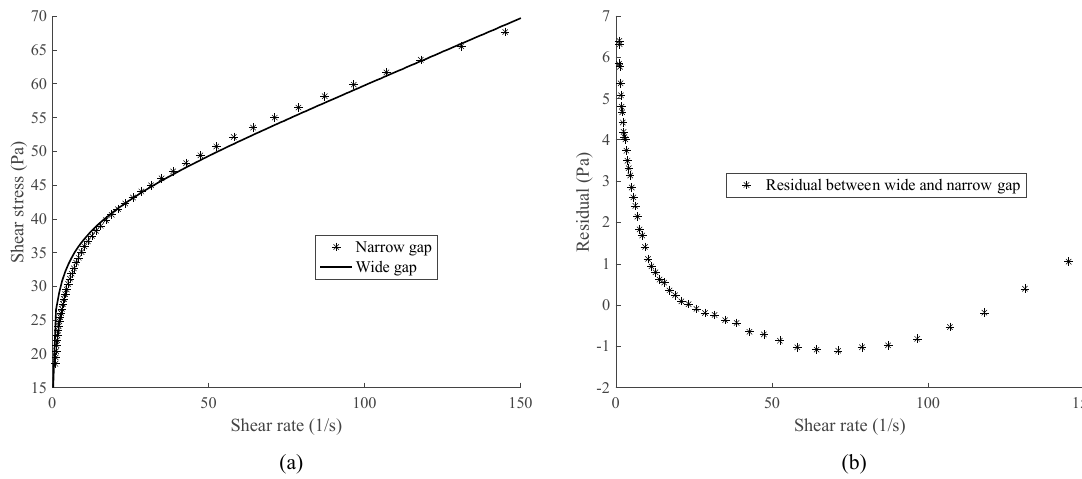
Figure 3. ( a ) Rheograms of Tomato ketchup obtained using both the narrow and wide gap geometry rheometers. ( b ) Residuals between the rheograms from wide and narrow gap.